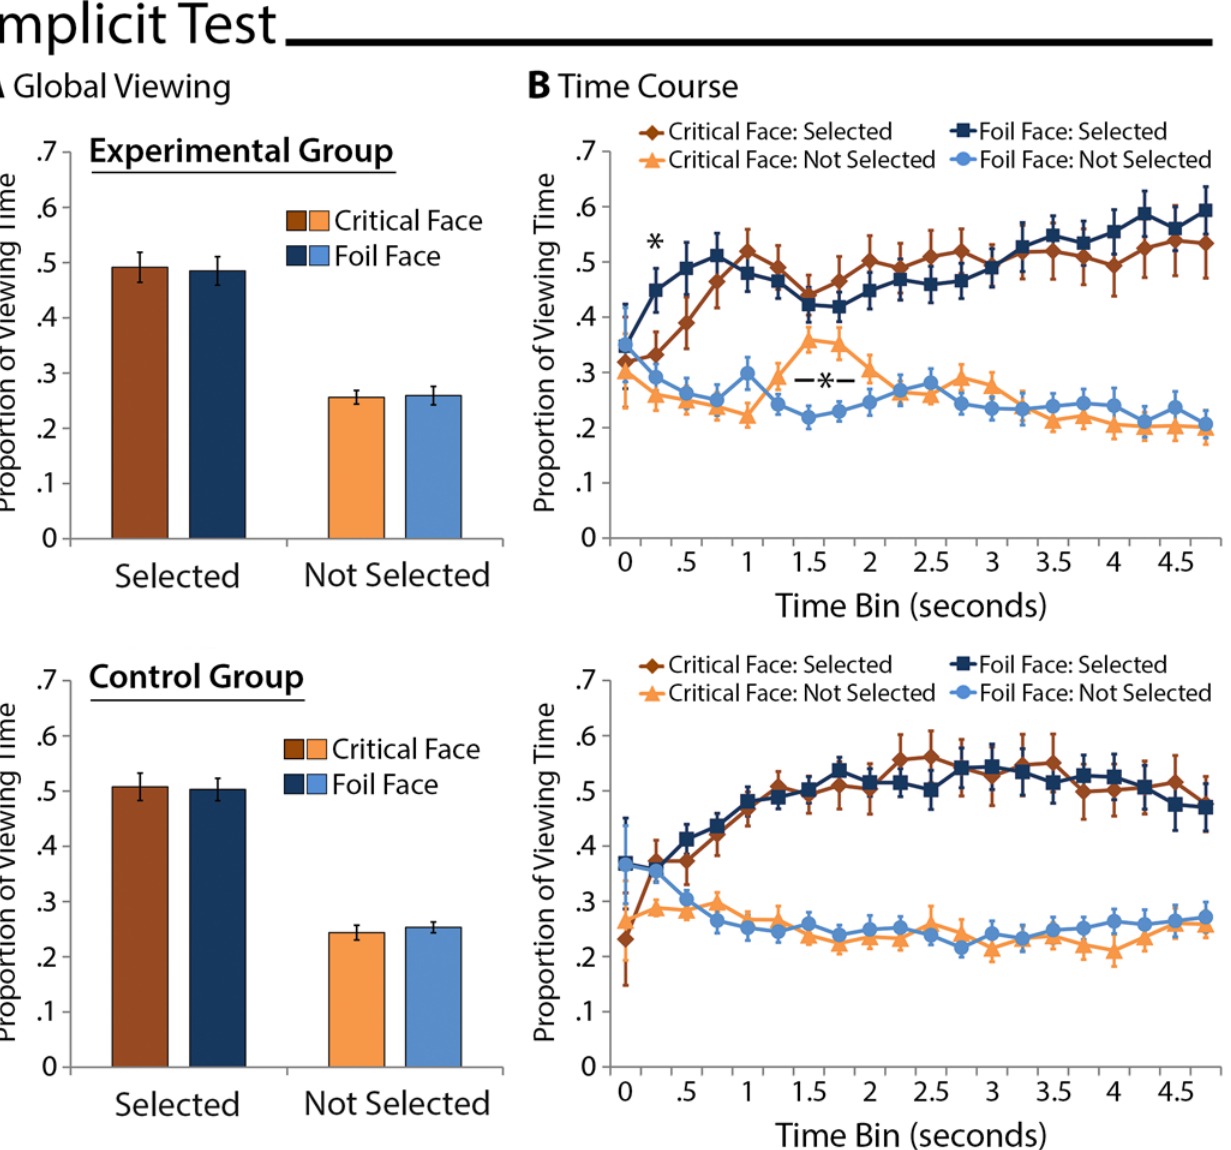
Fig 4. Implicit Memory-Based Viewing Effects. A) Proportion of total viewing time directed to faces of interest collapsed across the duration of the entire test trial for the experimental group (top) and the control group (bottom). More time was spent looking at faces that happened to have been selected, but there were no effects of memory in viewing patterns. B) Proportion of total viewing time direct to faces of interest broken down into 250ms time bins starting with 3-face display onset. Faces that happened to have been selected were prioritized, but effects of memory on the viewing behavior of experimental group participants (top) are also evident; the same effects are absent from control data (bottom). Error bars indicate standard errors of the